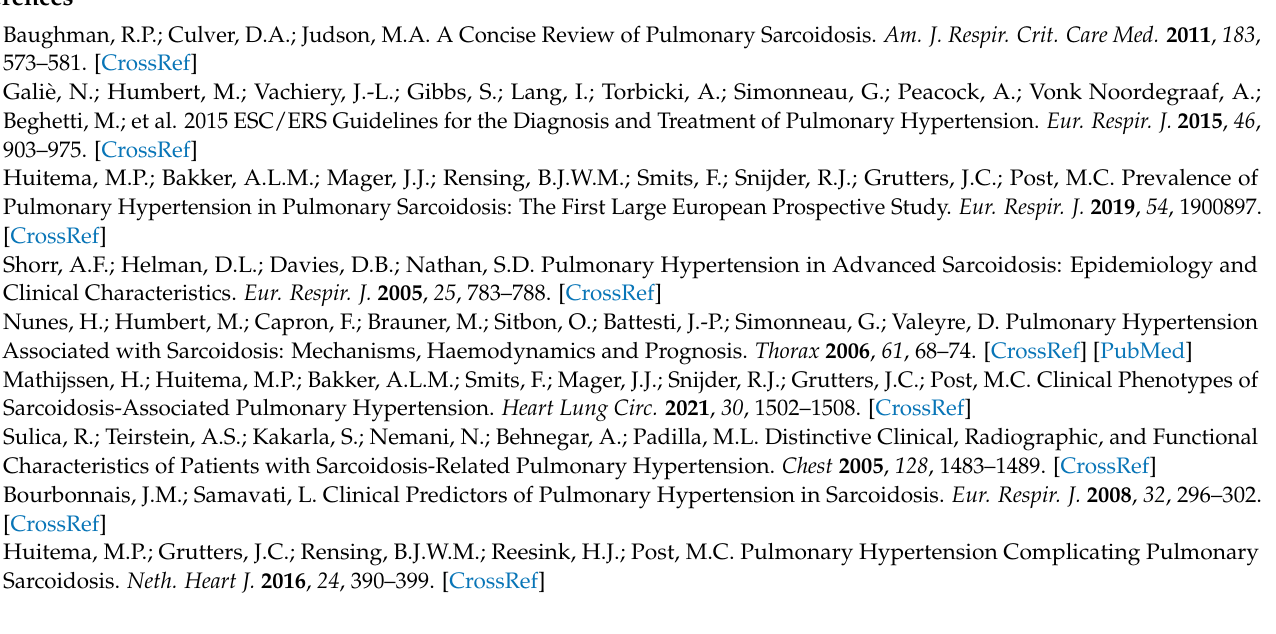
Table S2: Baseline characteristics of SA patients with a variant in diagnostic gene panel compared to SA patients without a variant. Table S3: Overview of rare variants in biologically relevant genes in which ≥ 15% of the SA patients carry a rare